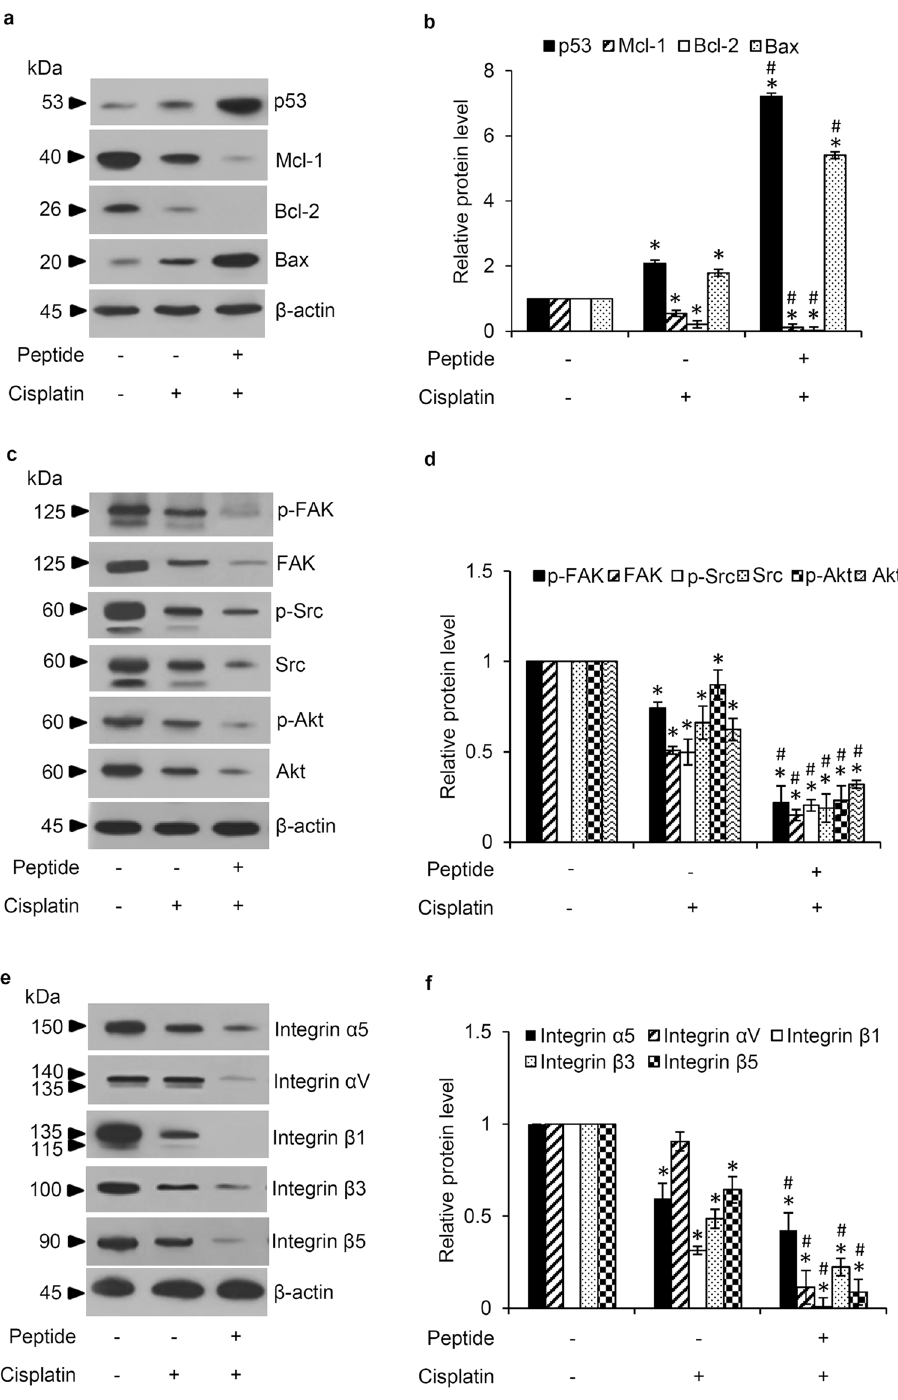
Figure 5. Pretreatment with 0.4 M NaCl peptide obtained from L. squarrosulus significantly sensitizes cisplatin-induced cell death through regulation of apoptosis and integrin-mediated survival pathway in human lung cancer H460 cells. ( a , b ) The protein levels of Mcl-1 and Bcl-2 were significantly decreased while tumor suppressor p53 and pro-apoptosis Bax protein levels were obviously increased in comparison with H460 cells treated with cisplatin alone. ( c , d ) Related survival proteins (FAK, p-FAK, Src, p-Src, Akt, p-Akt) and (e, f) integrins (α5, αV, β1, β3, β5) were considerably decreased as a result of peptide preincubation in cisplatin-treated cells compared to the cells treated with cisplatin alone. Values are means of three independent experiments ± SD. * p < 0.05 versus non-treated control cells, # p < 0.05 versus the cells only treated with